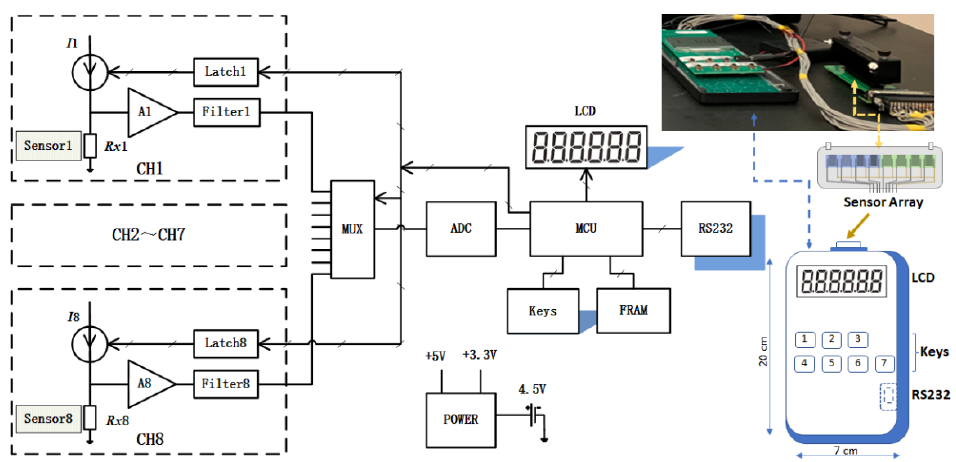
Figure 1. Block diagram for the design of the electronic board for coupling to the nanostructured chemiresistor array. Insets in the right panel: photo of the HCD interface with the sensor array, and the schema showing the layout. Component descriptions—CH1 to CH8: Channel 1 to 8 modules; Sensor1–Sensor8: chemical array sensor 1 to 8 with corresponding resistances from Rx1~Rx2, re-